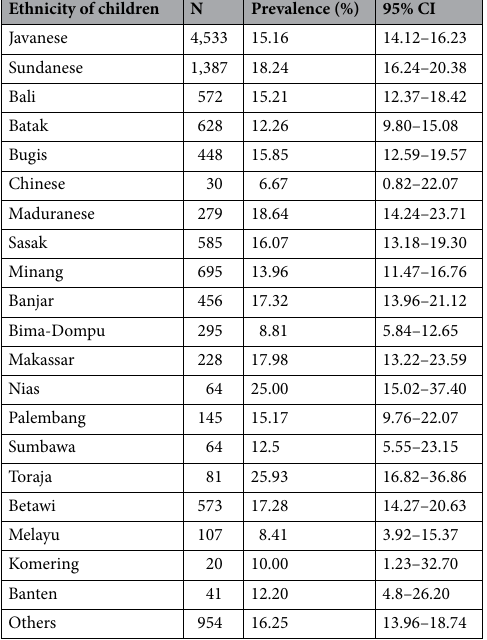
Table 3. Ethnicity and toothache among children in Indonesia,